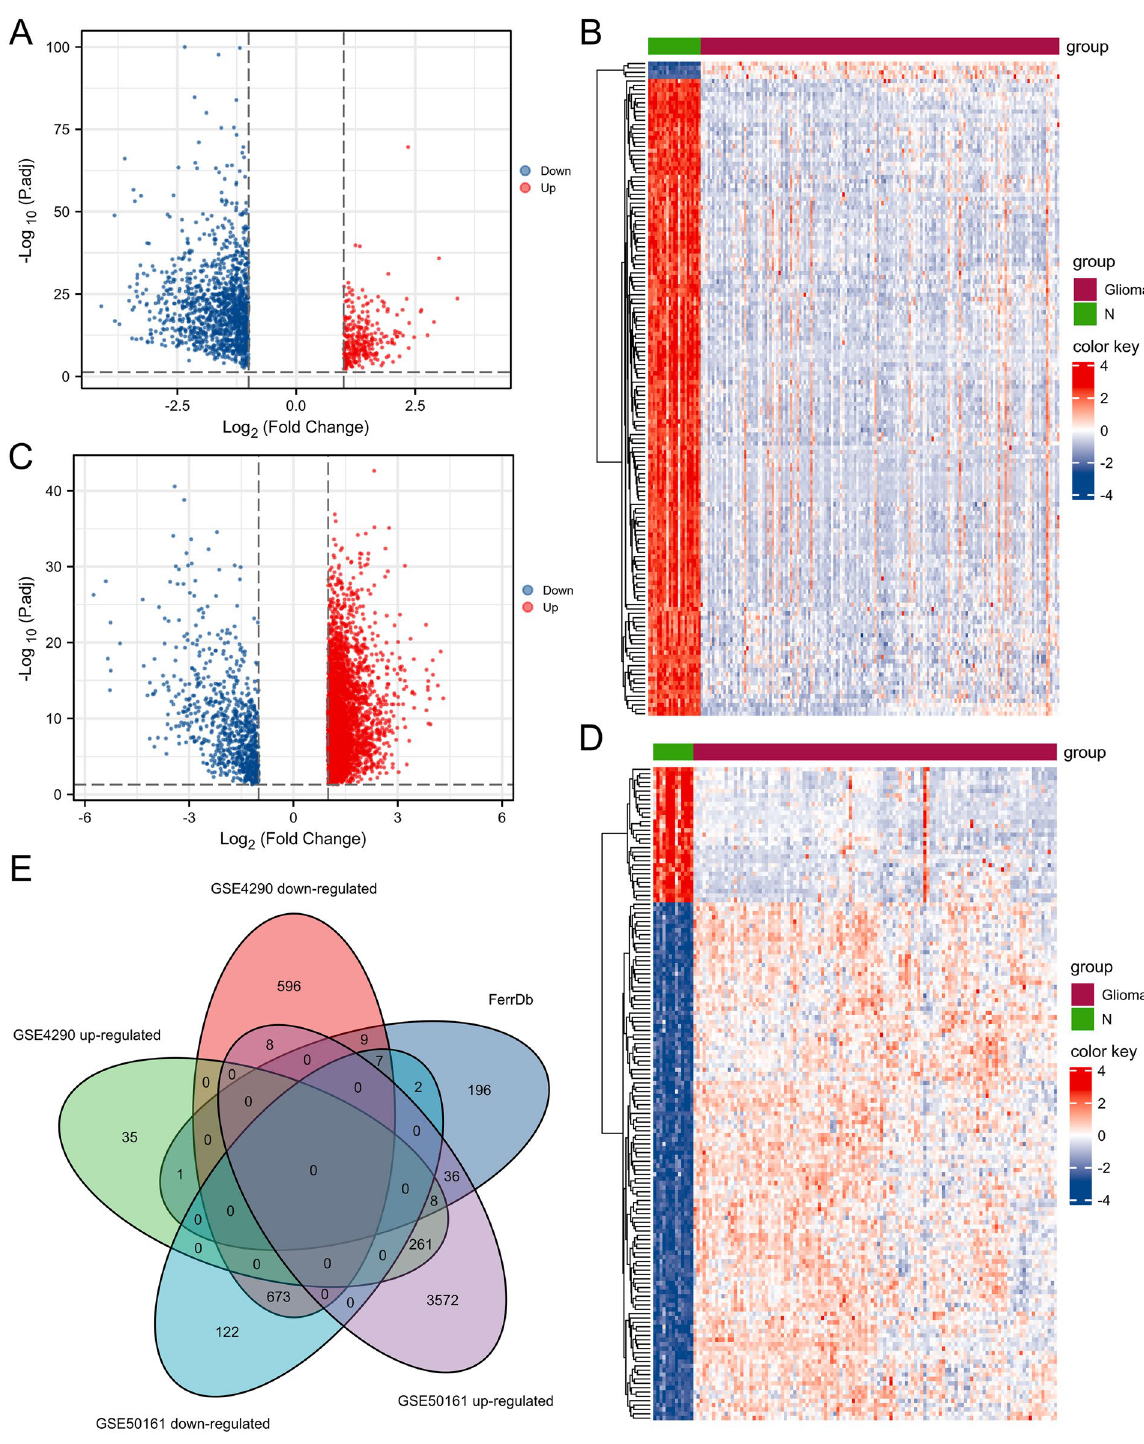
Figure 2. Identification of ferroptosis-related DEGs in GEO database. Volcano plots and heatmaps of DEGs in GSE4290 dataset ( A , B , respectively) and GSE50161 dataset ( C , D , respectively). The Venn diagram ( E ) of the intersection among up-regulated DEGs, down-regulated DEGs and ferroptosis-related